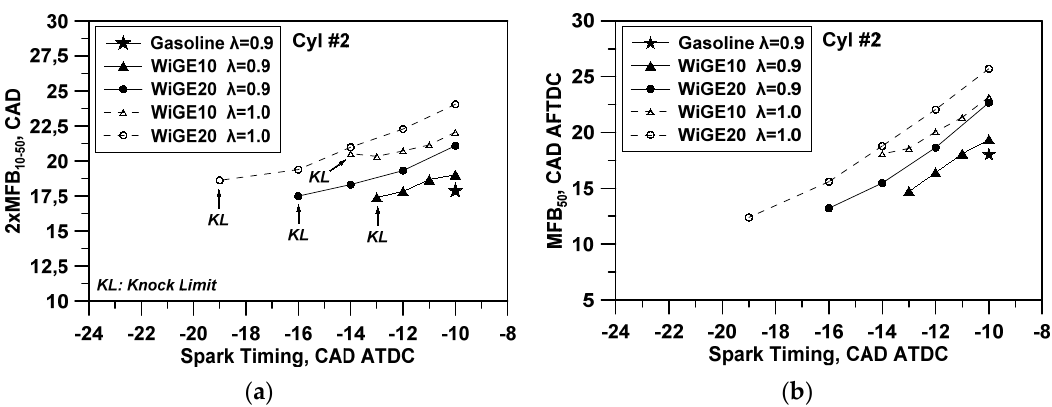
7 of 12 Figure 2. In-cylinder pressure trace and rate of heat release at SA = − 10 CAD ATDC, λ = 0.9. Figure 3 shows the relationship between water content and combustion duration and phasing, at different spark timings and relative A/F ratios and WiGEs, considering a representative engine cylinder (Cyl #2). For each spark timing sweep, a clear indication of knock-limit (KL) point is depicted in Figure 3a. This indication of KL points extends to the other figures proposed below. In agreement with the pressure traces shown in Figure 2, at SA = − 10 CAD ATDC and λ = 0.9, the use of WiGE prolongs the combustion duration (Figure 3a) and delays the combustion phasing (Figure 3b). On the other hand,